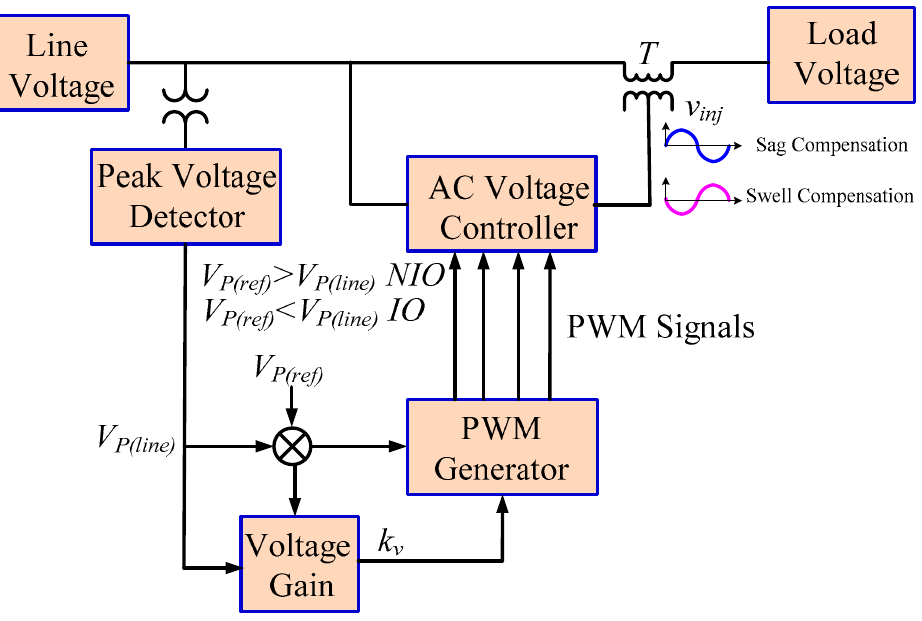
Figure 10. Block diagram of the voltage compensation process.